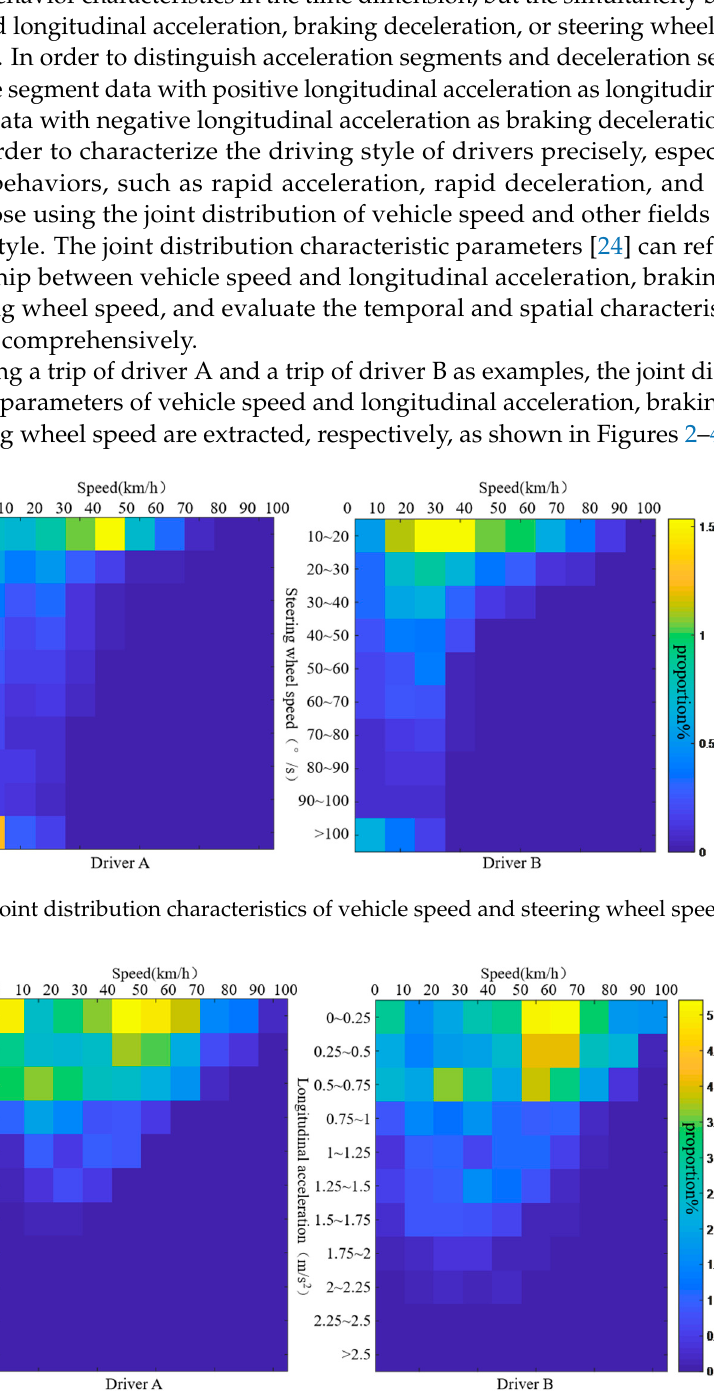
Figure 4. Joint distribution characteristics of vehicle speed and brake deceleration. 3.3. Optimization of Driving Style Characteristic Parameters The driving style characteristic parameters of this paper include a plurality of statis- tical parameters of NEV big data, the percentage of intervals, and three different joint dis- tribution characteristics, totaling 383 dimensions. In order to minimize the resources re- quired for calculation and maximize the retention of the information contained in the driv- ing behavior characteristic parameters, the characteristic parameters need to be optimized for dimensionality reduction. In this paper, we used principal component analysis algorithm to orthogonally trans- form the characteristic parameters of driving behavior. The characteristic parameters that may have a certain correlation with each other can be transformed into a linear and un- correlated principal component. As shown in Figure 5, the cumulative contribution rate of the first 35 principal components is over 85%. Therefore, the first 35 principal compo- nents can be used to represent the driving styles. The dimensionality reduction optimiza- tion processing reduces the complexity of the characteristic parameter matrix and can im- prove the calculation efficiency.